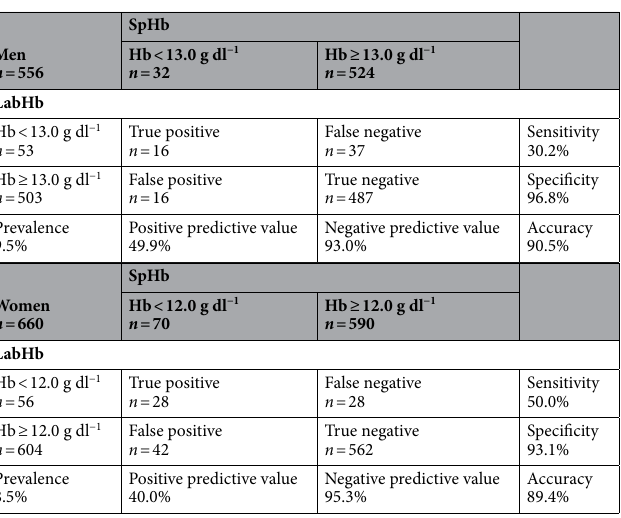
Table 2. Diagnostic characteristics of SpHb measurement compared to with LabHb for the diagnosis of anaemia defined as Hb < 13.0 g dl −1 for men and Hb < 12.0 g dl −1 for women.